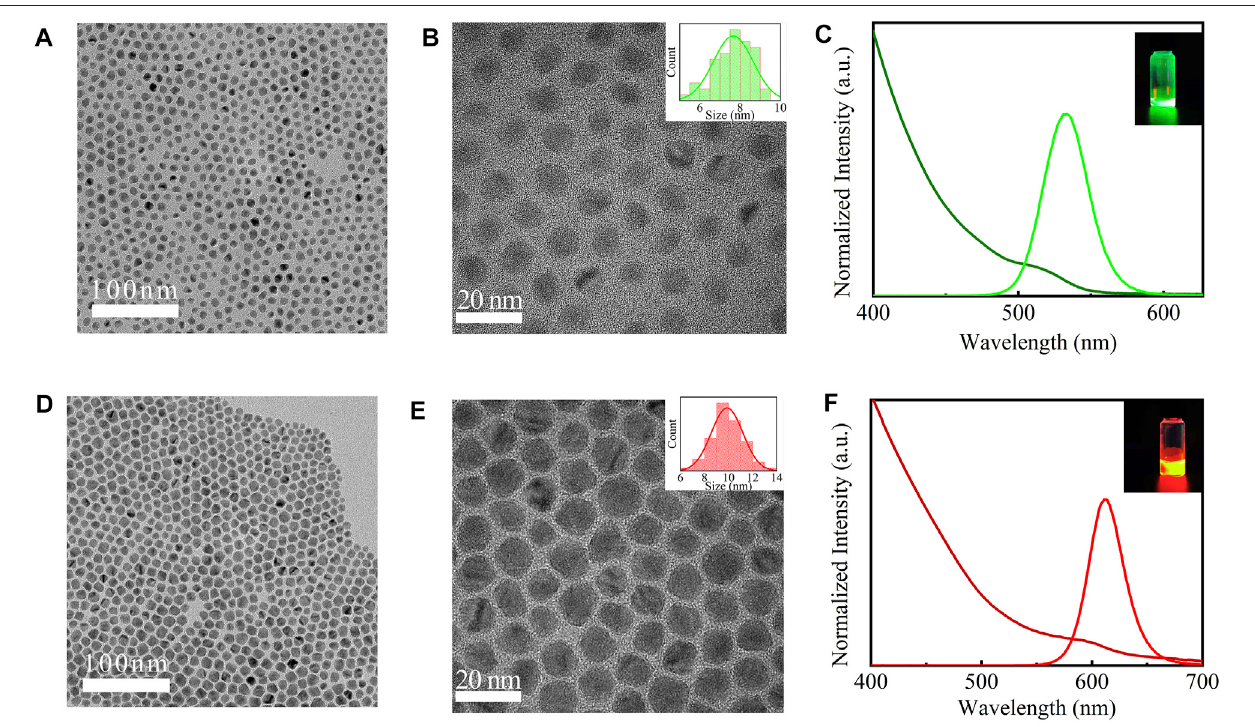
FIGURE 2 | PL decay curves of the CdZnSeS/ZnSeS QDs at room temperature. (A) Green QDs. (B) Red QDs. PL, photoluminescence; QDs, quantum dots.